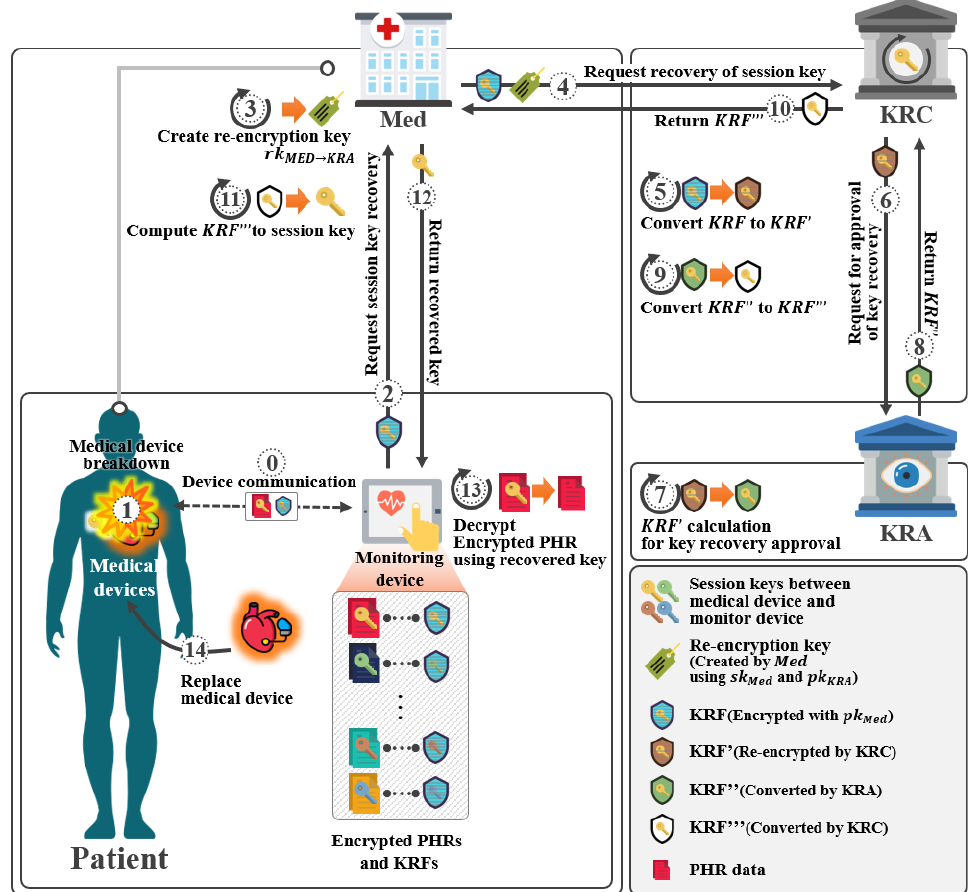
Figure 9. Scenario of proposed